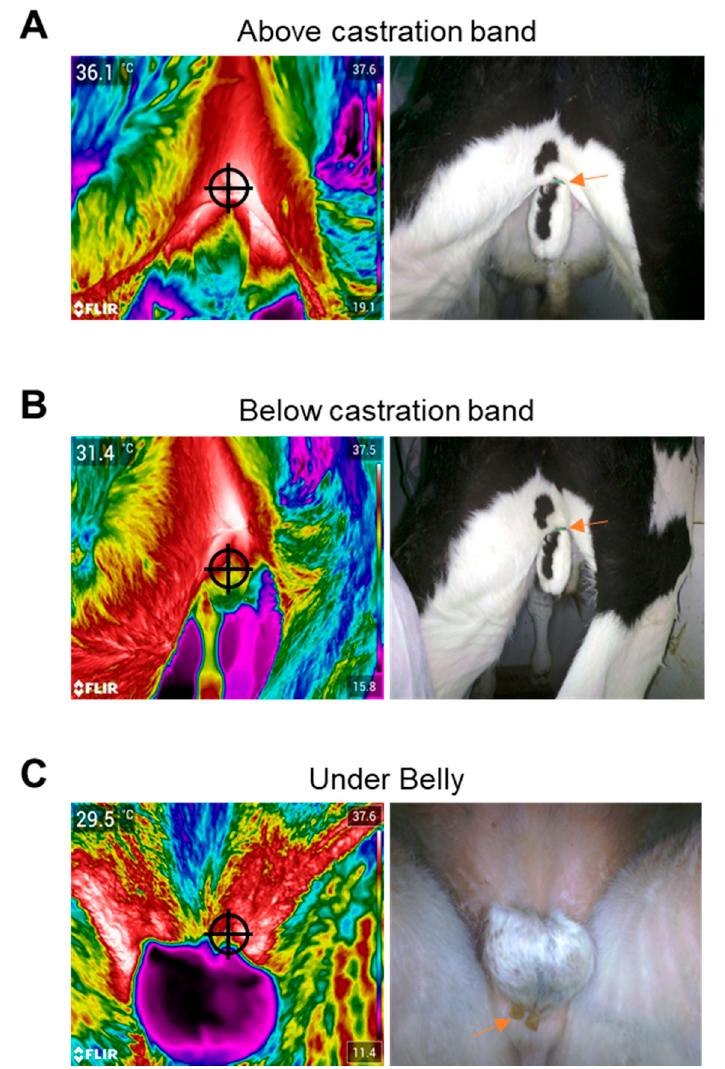
Figure 6. Infrared imaging of animals with castration bands. Representative infrared images (left) and corresponding photographs (right) are presented for ( A ) above the castration band, ( B ) below the band, and ( C ) the underbelly of the animal. Cross hairs (left-most images) indicate the point at which the temperature was registered. Orange arrows (right-most images) indicate the bands. The temperatures were quantitated and are presented in Figure 7.